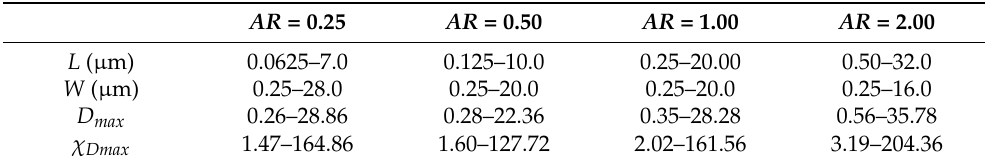
range is required to determine the sizing errors as shown in Section 5. At λ = 0.55 µ m, the refractive index of liquid water is 1.333 + i 1.960 × 10 − 9